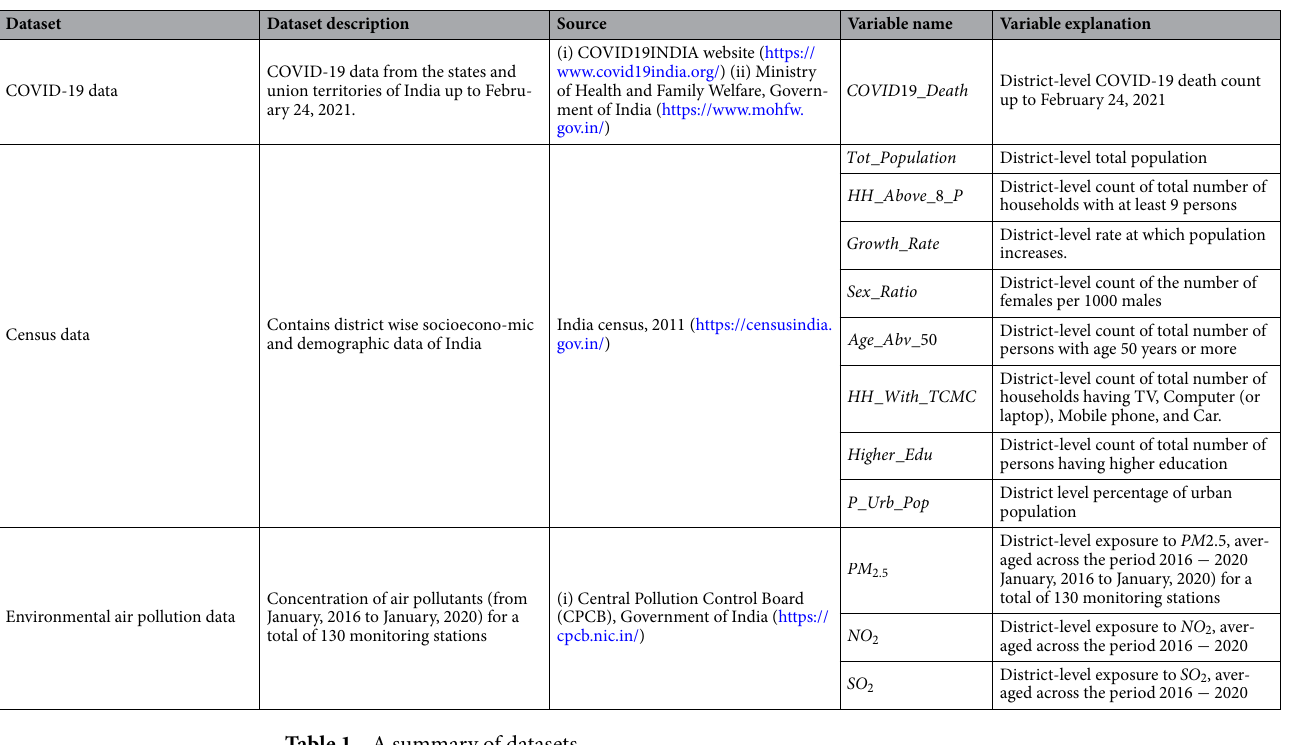
Table 1. A summary of